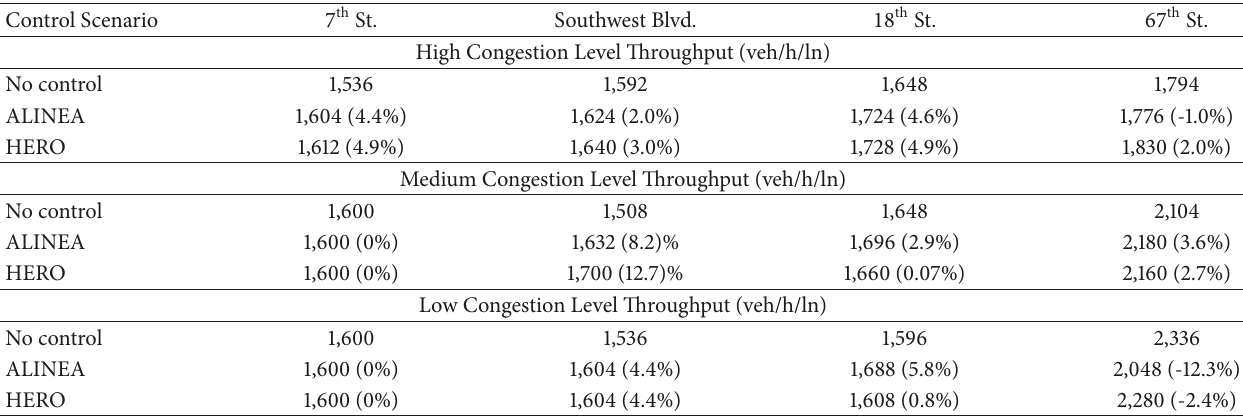
Table 6: Throughput and percentage change of throughput for the three control scenarios.